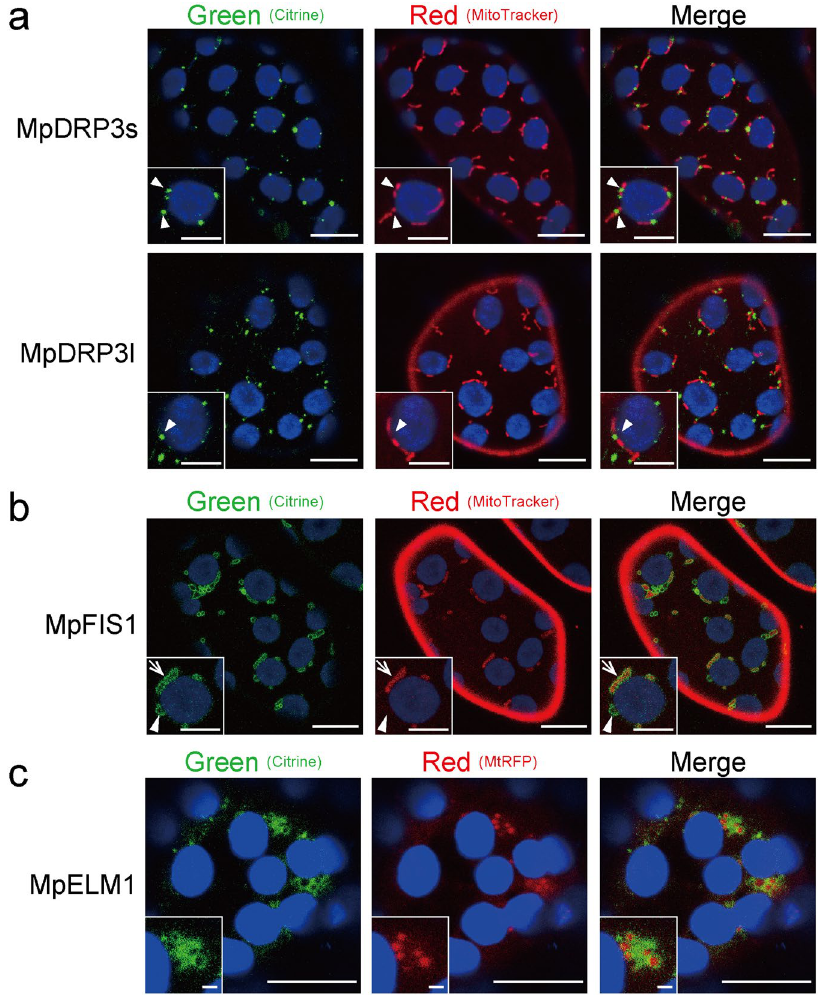
Figure 2. Intracellular localization of MpDRP3, MpFIS1 and MpELM1 in Marchantia thallus. ( a ) CLSM images of the epidermal cell expressing Citrine-MpDRP3s (upper panel) or Citrine-MpDRP3l (lower panel) and stained with MitoTracker (Bars = 10 µ m). Magnified images are shown in insets (Bars = 5 µ m). The arrowheads indicate Citrine signals localized to the constriction sites of mitochondria. ( b ) CLSM image of the epidermal cell expressing Citrine-MpFIS1 and stained with MitoTracker (Bars = 10 µ m). Magnified images are shown in insets (Bars = 5 µ m). The arrow indicates a mitochondrion and the arrowhead indicates a body not mitochondria. ( c ) Fluorescence image of the epidermal cell transiently transformed with Citrine-MpELM1 and MtRFP by particle bombardment (Bars = 10 µ m). Magnified images are shown in insets (Bars = 1 µ m). Blue signals were chlorophyll